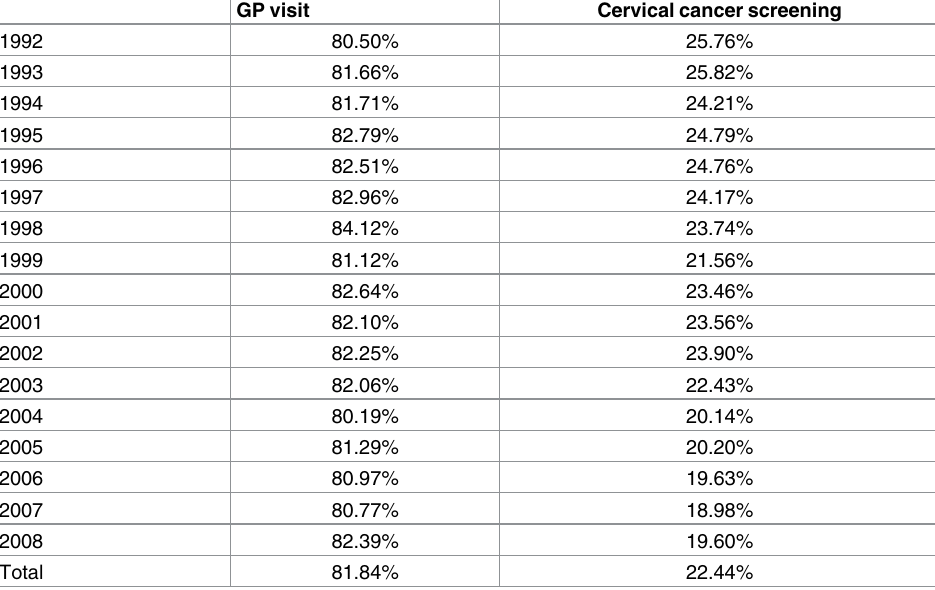
Table 1. Uptake rate for a GP visit and cervicalcancer screening examination during the 17 years period from 1992 to 2008in Great Britain. GP